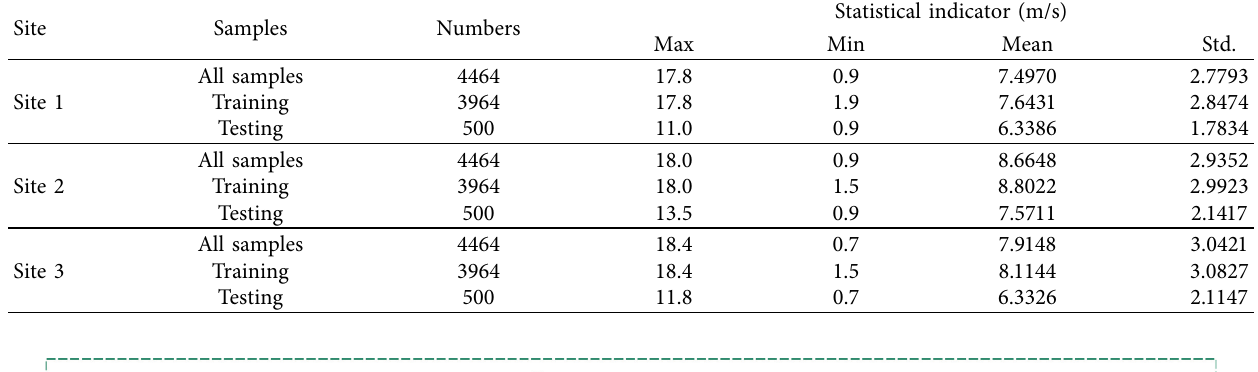
Table 4: Data structure of three selected datasets in Penglai, Shandong